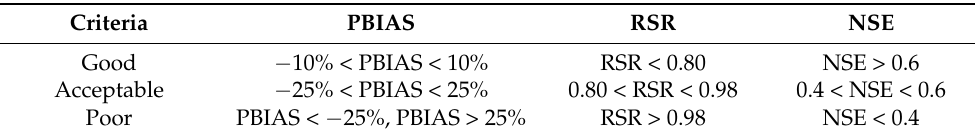
Table 2. Model evaluation criteria thresholds